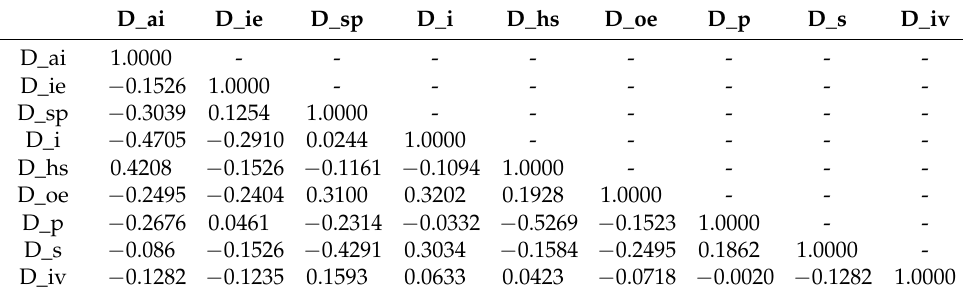
Table 5. Correlation coefficient